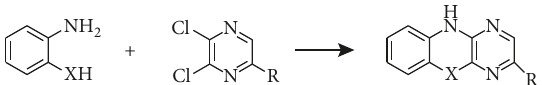
Figure 1: Previously published syntheses of 10 H -pyrazino[2,3-b] [1,4]benzothiazines (X � S, R � H or Cl) and 10 H -pyrazino[2,3-b] [1,4]benzoselenazine (X � S, Se; R � H,